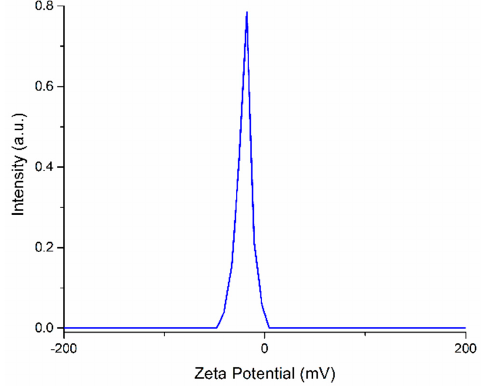
Figure 2. Zeta potential distribution for magnesium-doped hydroxyapatite (Ca 10-x Mg x (PO 4 ) 6 (OH) 2 , x Mg = 0.1) (10MgHAp) nanoparticles suspension.